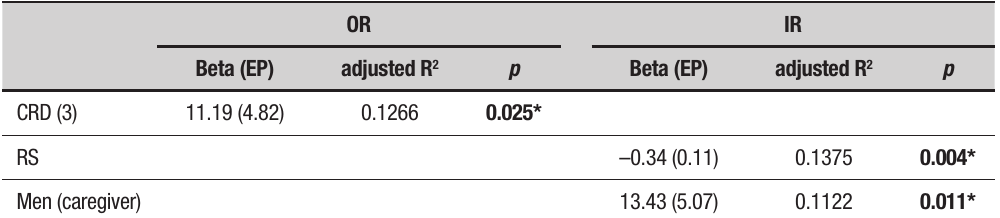
Table 5. Multivariate linear regression analysis of greater organizational religiosity and intrinsic religiosity (PDUREL) of the family